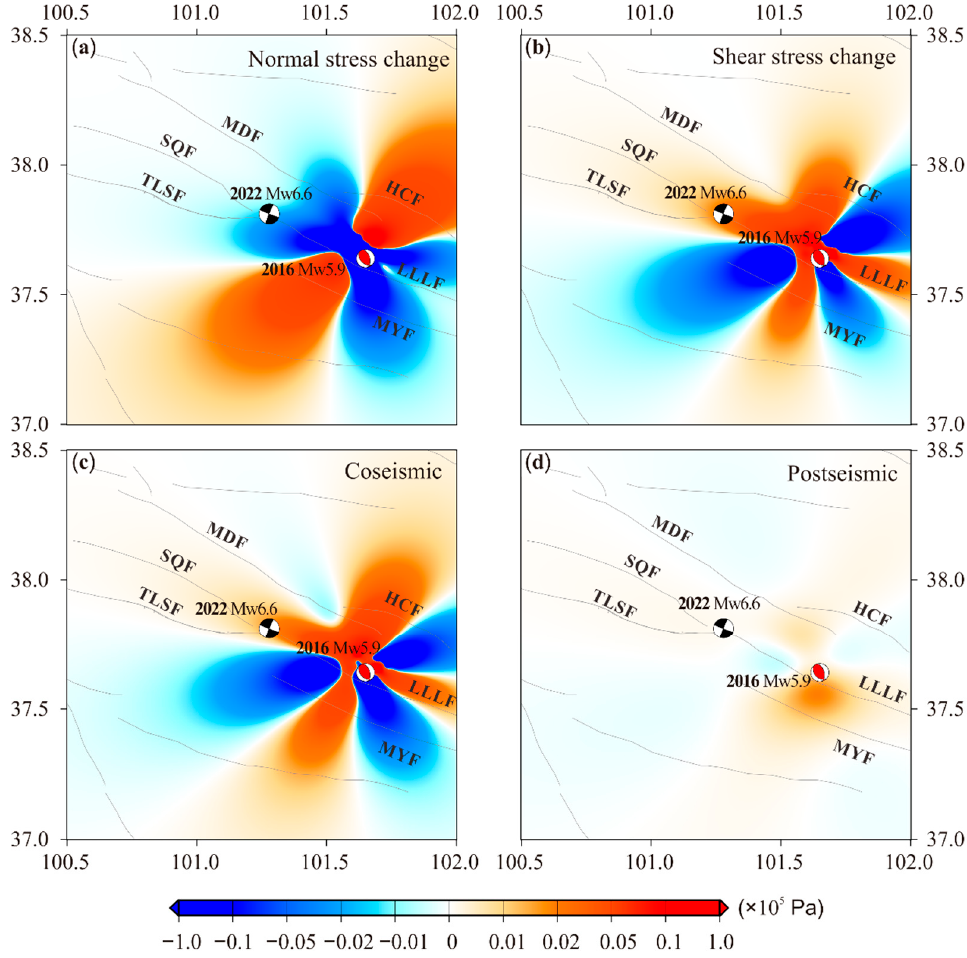
Figure 9. Stress change associated with the 2016 Menyuan earthquake. ( a ) Coseismic normal stress change. ( b ) Coseismic shear stress change. ( c ) Coseismic Coulomb stress change. ( d ) Postseismic Coulomb stress change.